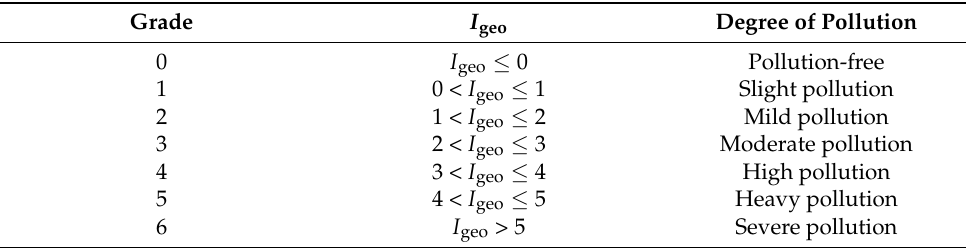
Table 2. Indices of geoaccumulation and degrees of